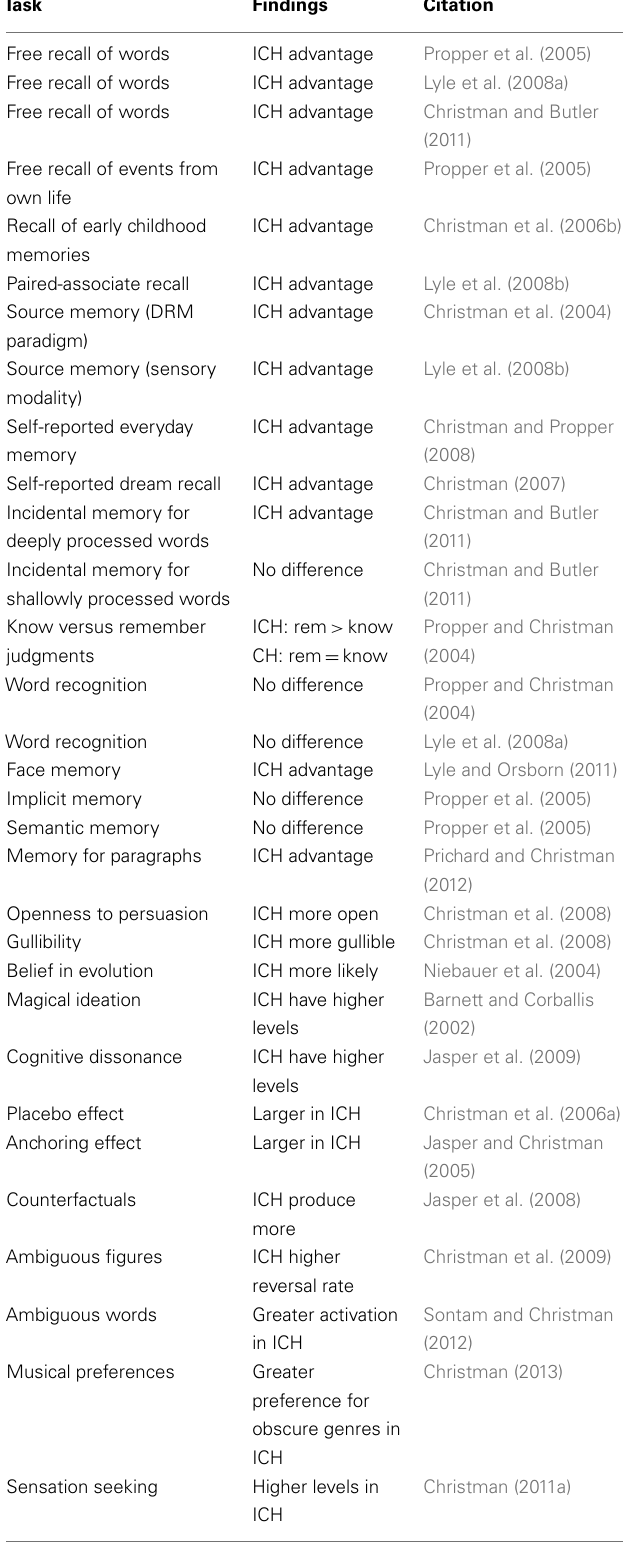
Table 1 | Percentages of female and male participants, classified according to both direction and degree of handedness.